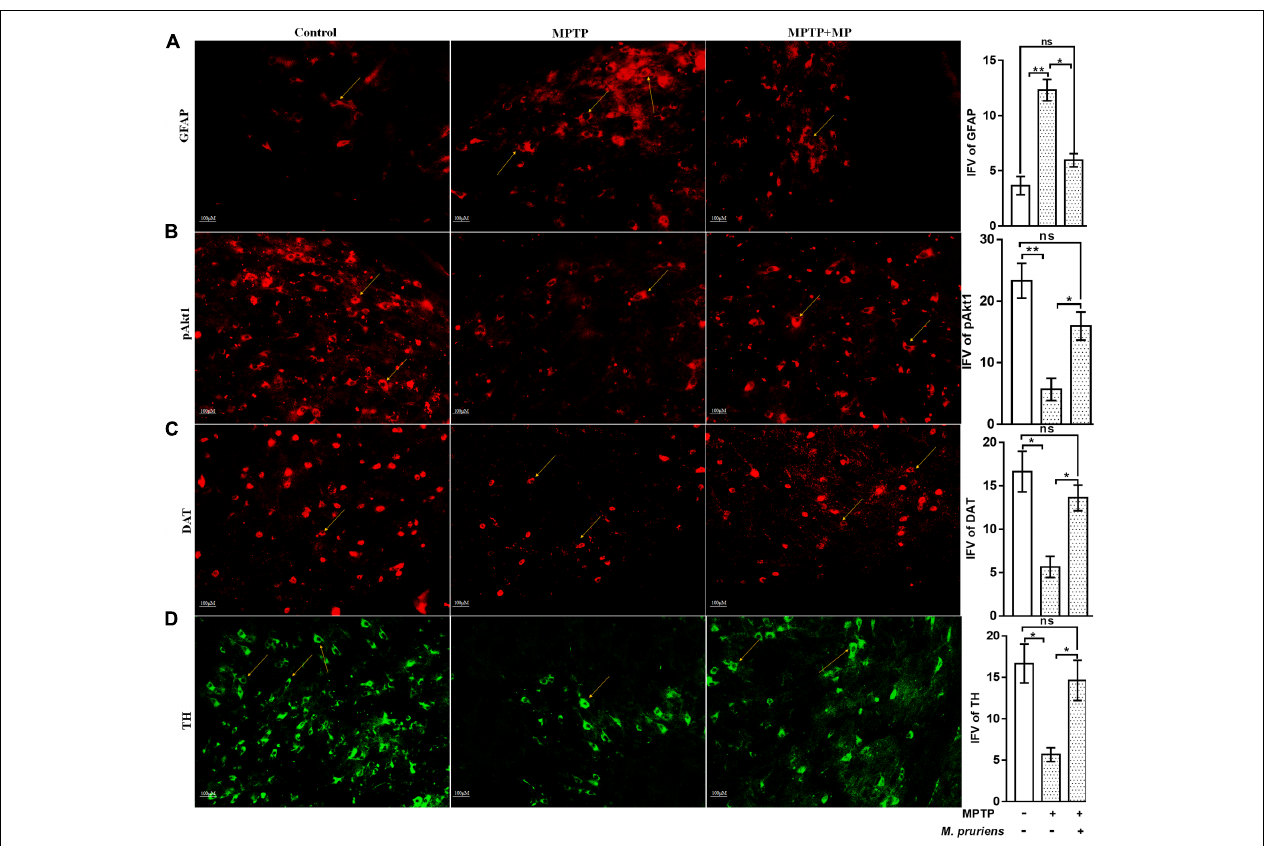
FIGURE 5 | Immunofluorescence expression of GFAP, pAkt1, DAT, and TH in SNpc. of CONT, MPTP, and MPTP+Mp mice by using Image J Software at 20x magnification. The MPTP intoxicated PD mice showed significantly enhanced expression level of GFAP positive cells (A) as compared to control, while on Mp supplementation in PD mice showed significantly alleviated expression level of GFAP positive cells as compared to MPTP mice. On the contrary immunofluorescence staining of pAkt1 positive cells were reduced in MPTP treated mice (B) while Mp treatment substantially enhanced the expression of pAkt1. Similarly, DAT (C) and TH (D) positive dopaminergic neurons expression were reduced in MPTP treated mice while Mp treatment in MPTP treated mice significantly enhanced the expression of DAT and TH. Values are expressed as mean ± SEM of IFV ( ∗ p < 0.05, ∗∗ p < 0.01, n = 3). ns, non-significant; GFAP, glial fibrillary acidic protein; DAT, dopamine transporter; TH, tyrosine